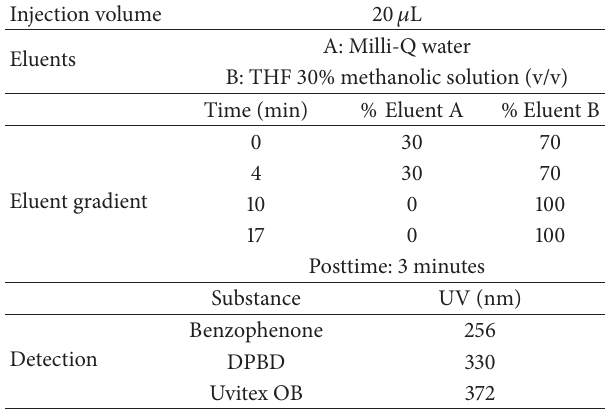
Table 1: High performance liquid chromatography parameters employed in the analysis of Benzophenone, diphenylbutadiene (DPBD), and